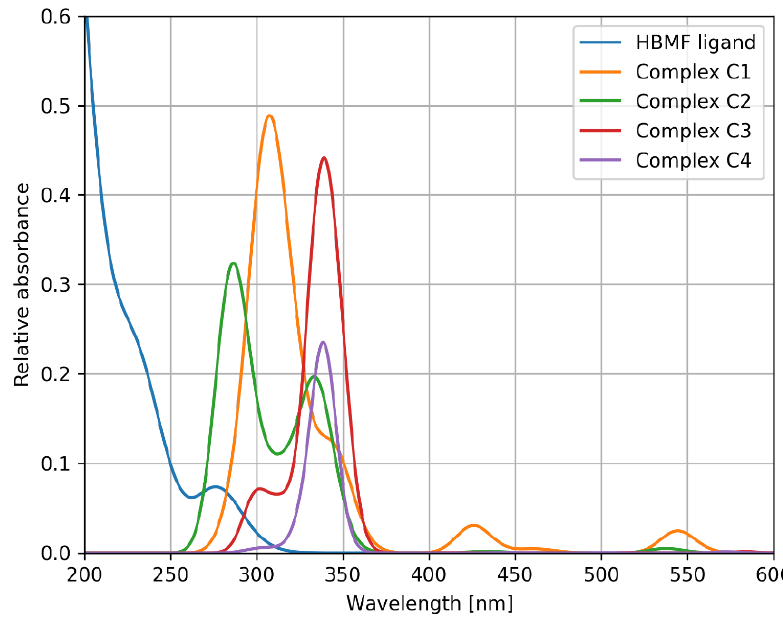
Figure 11. Simulated UV spectra of studied molecules.